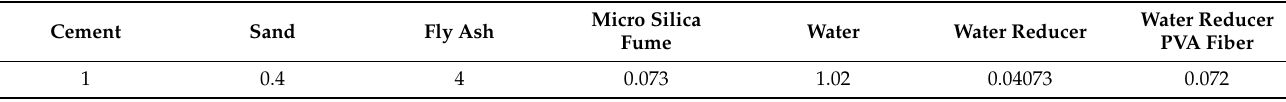
Table 2. ECC mix ratio in mass.